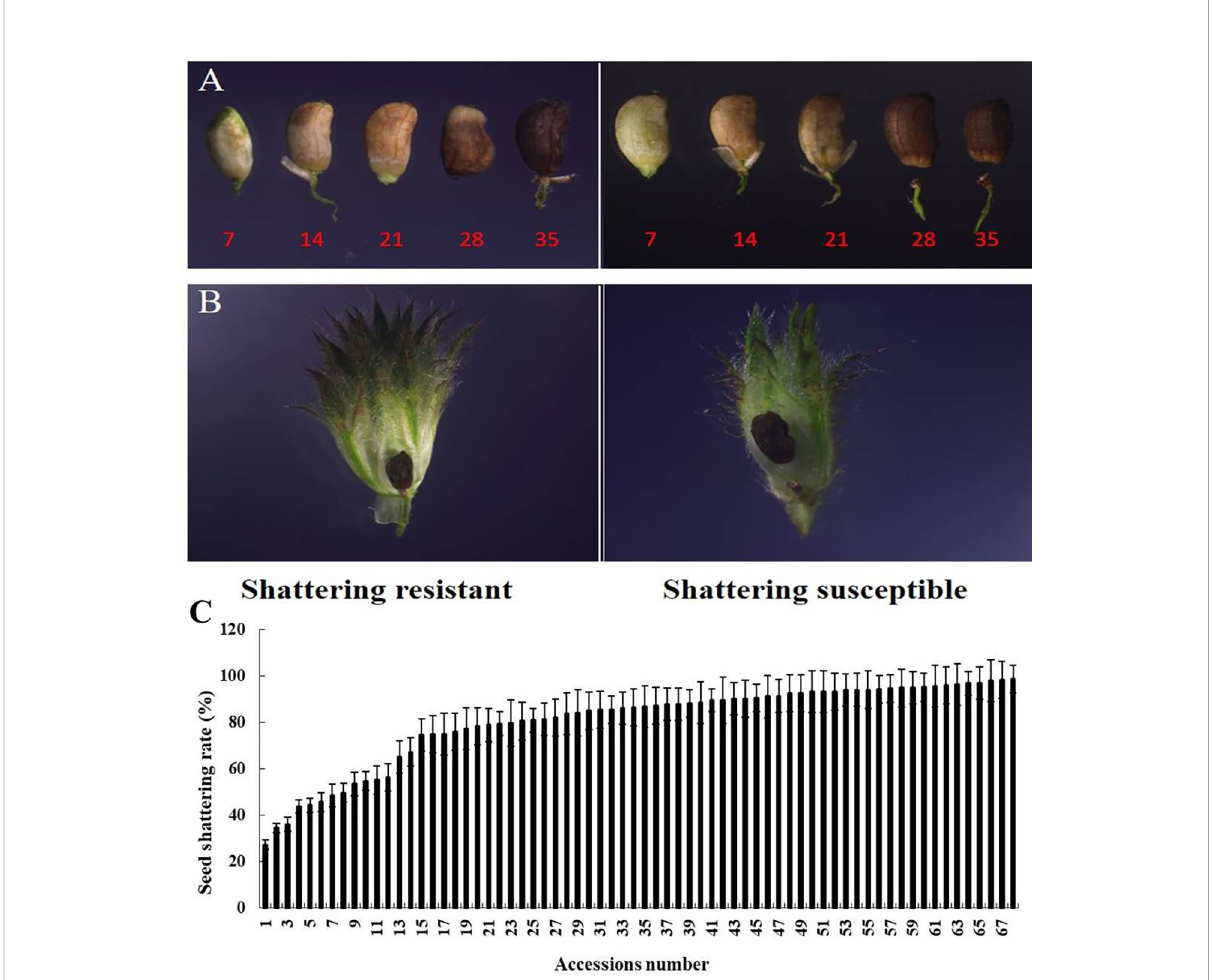
FIGURE 1 Different seed shattering (SS) habits of the stylo accessions. (A) Time course changes in the SS position of the SS-resistant and SS-susceptible accessions at 7, 14, 21, 28, and 35 days after fl owering (DAF). (B) SS position of the SS-resistant and SS-susceptible accessions at 28 DAF in the in fl orescence. (C) Average SS rate of the 68 stylo accessions. Bars indicate the mean ± SD.